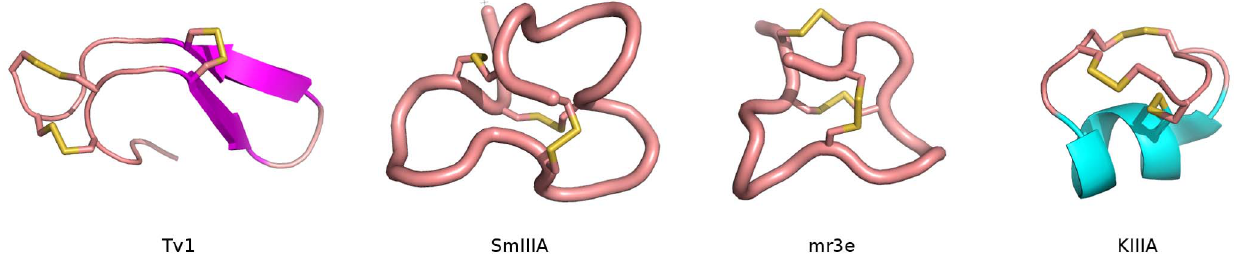
Figure 4. Structural comparison of Tv1 teretoxin and M-superfamily conotoxins. Comparison of the NMR structure of Tv1 with that of M superfamily conotoxins SmIIIA, mr3e, and KIIIA reveals significant structural differences between Tv1 and these conotoxins despite all having the same cysteine scaffold CC-C-C-CC. All structures are shown in cartoon representation with disulfide bonds highlighted in yellow. All figures were prepared using PyMol (www.pymol.org). Conotoxin structural references are as follows: MrIIIe [33] SmIIIA [61] and KIIIA [62].